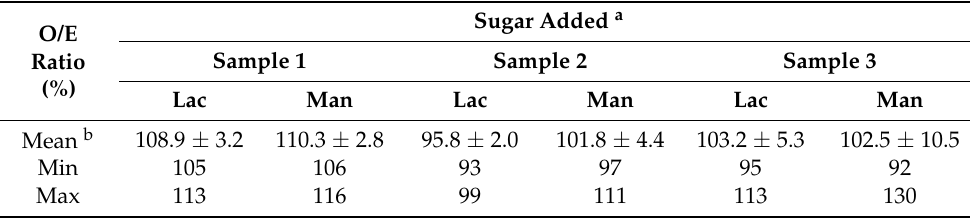
Table 2. Recovery of lactulose and mannitol from three different spiked urine samples. O/E